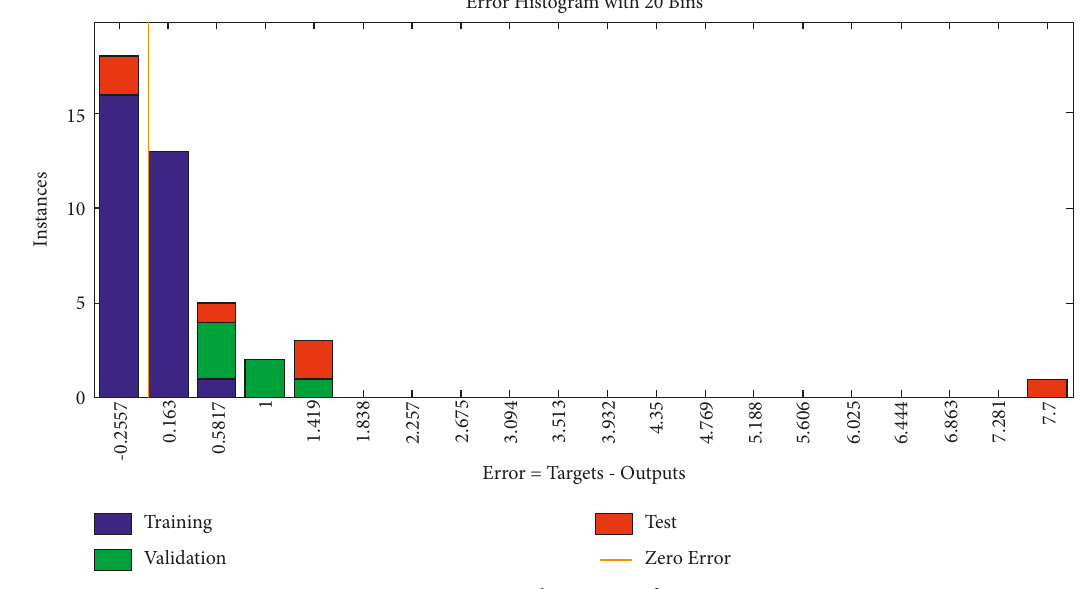
Figure 4: Error histogram of ANN.